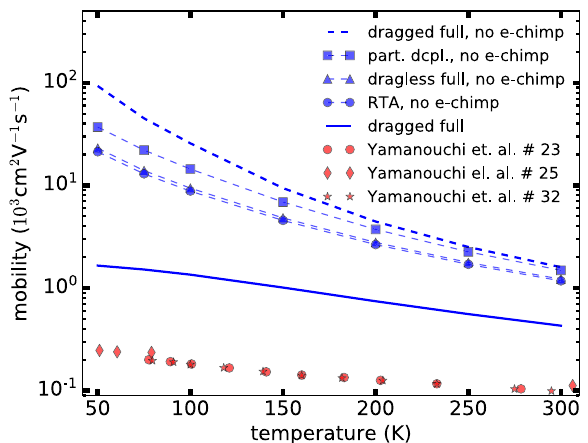
Fig. 5 Temperature dependence of the mobility of silicon for an n -type carrier concentration of 2 × 10 19 cm − 3 . The red circles are measurements by Yamanouchi et. al. 53 on samples 23, 25, and 32, with dopant densities 2.28 × 10 19 , 2.42 × 10 19 , and 3.35 × 10 19 cm − 3 , respectively.